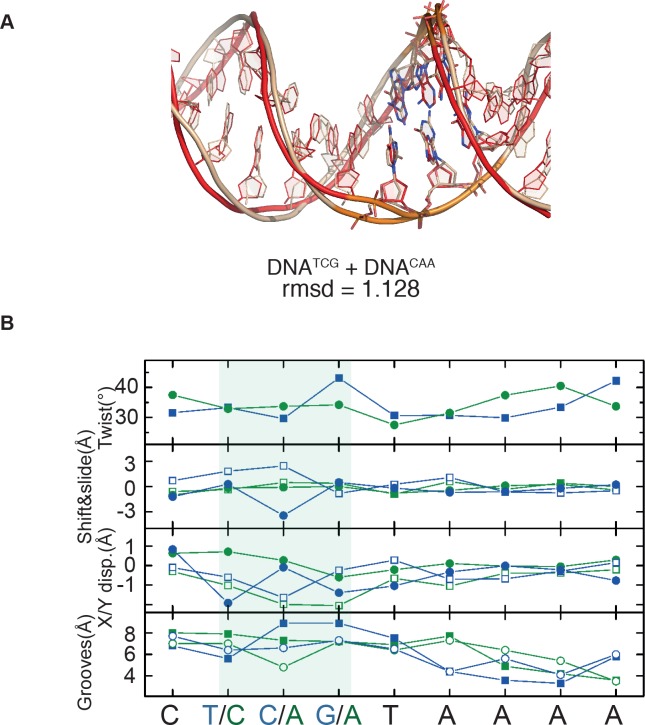
Paiwise comparison of two DNA molecules.(A) Pairwise comparisons of DNATCG (wheat) and DNACAA (red); (B) Helicoidal parameters for HOXB13-DNATCG (blue) and HOXB13-DNACAA (green). Top: Helical twist; Middle top: shift (squares) and slide (circles); Middle bottom: X- (squares) and Y-displacements (circles); Bottom: Minor groove width (squares) and major groove depth (circles). The most pronounced differences are found for the TCGT and CAAT positions.